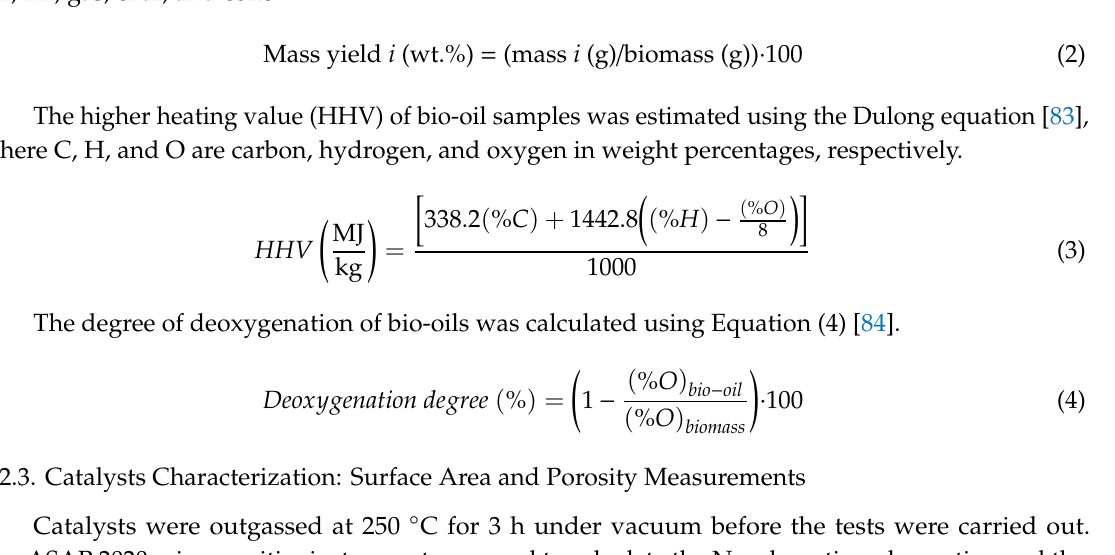
Table S1: Properties of the Lignocellulosic Biomass used for Catalytic Pyrolysis Experiments on Dry Basis, Figure S1: XRD pattern of H-ZSM-5 (Si / Al = 25) using monochromatic K α radiation (30–40 kV and 40–50 mA), Figure S2: XRD pattern of Al-MCM-41 (Si / Al = 25), performed at 40 kV and 200 mA with a scan rate of 1 ◦ / min over the range of 1–8 ◦ , Figure S3: Schematic Diagram of Catalytic Pyrolysis Reactor, Table S2: Gas composition for pyrolysis and catalytic pyrolysis of lignocellulose biomass